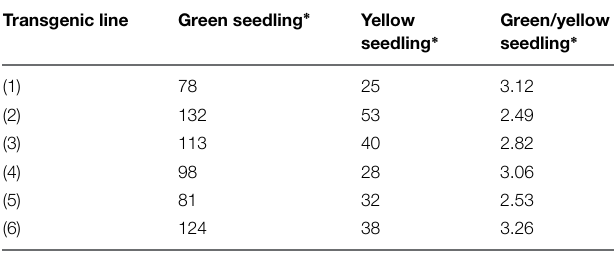
TABLE 3 | The segregation ratio of Knr:Kns populations of transgenic